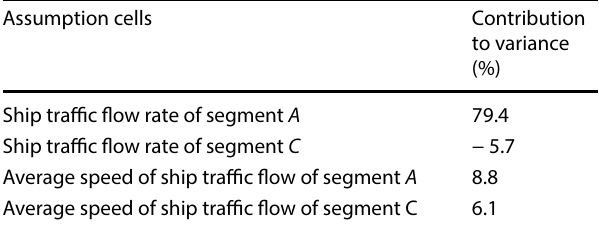
Table 8 Sensitivity analysis of the total number of ships affected Assumption cells Contribution